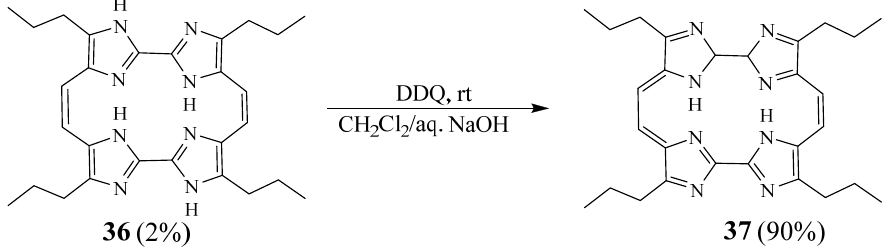
Figure 11. Synthetic route of macrocycle 37. (Reprinted with permission from ref. [26]. Copyright 2003 John Wiley and Sons).